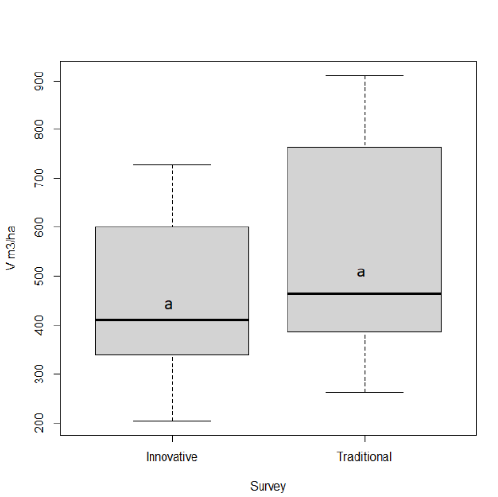
Figure 7 Boxplot of volume (V, m 3 /ha) computed for each plot by traditional and innovative survey. Boxes with different letters indicate a statistically significant difference